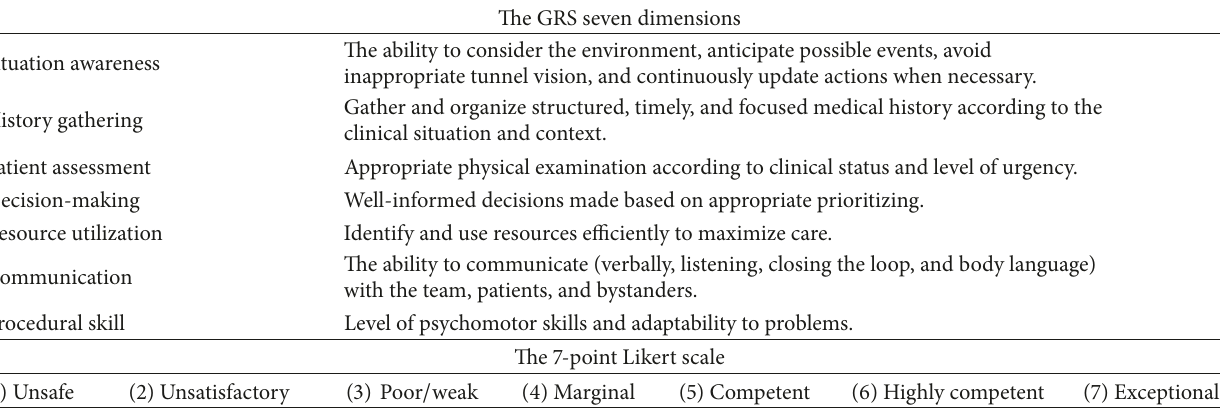
Table 1: The GRS seven dimensions and the scoring on the 7-point Likert scale. The GRS seven